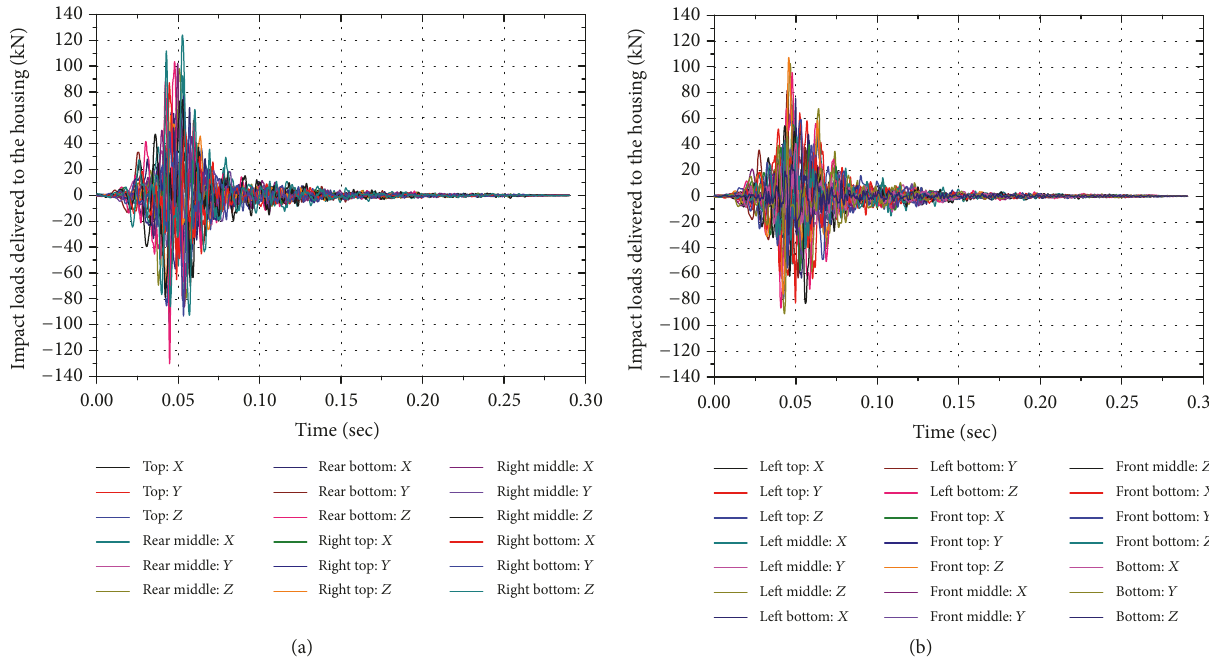
Figure 13: The load profile of impact on the housing in each path: (a) path numbers (1) ∼ (18), (b) path numbers (19) ∼